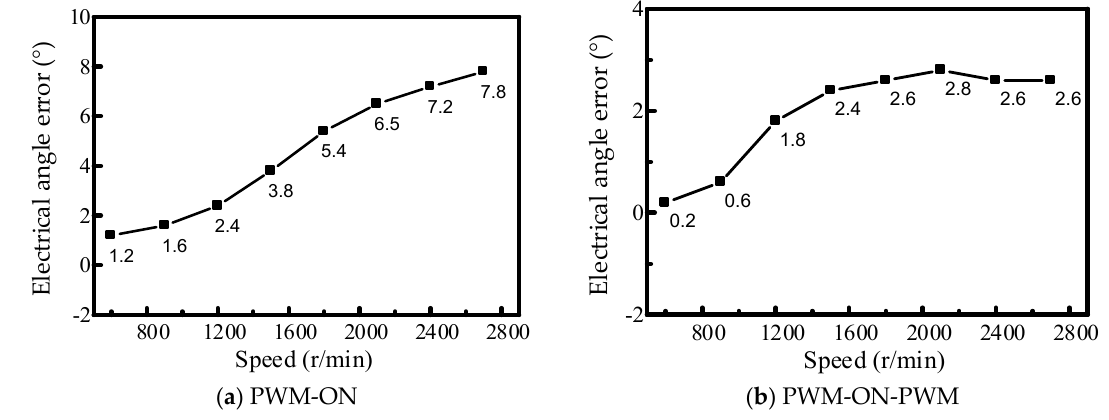
Figure 20. Electrical angle error of different methods.